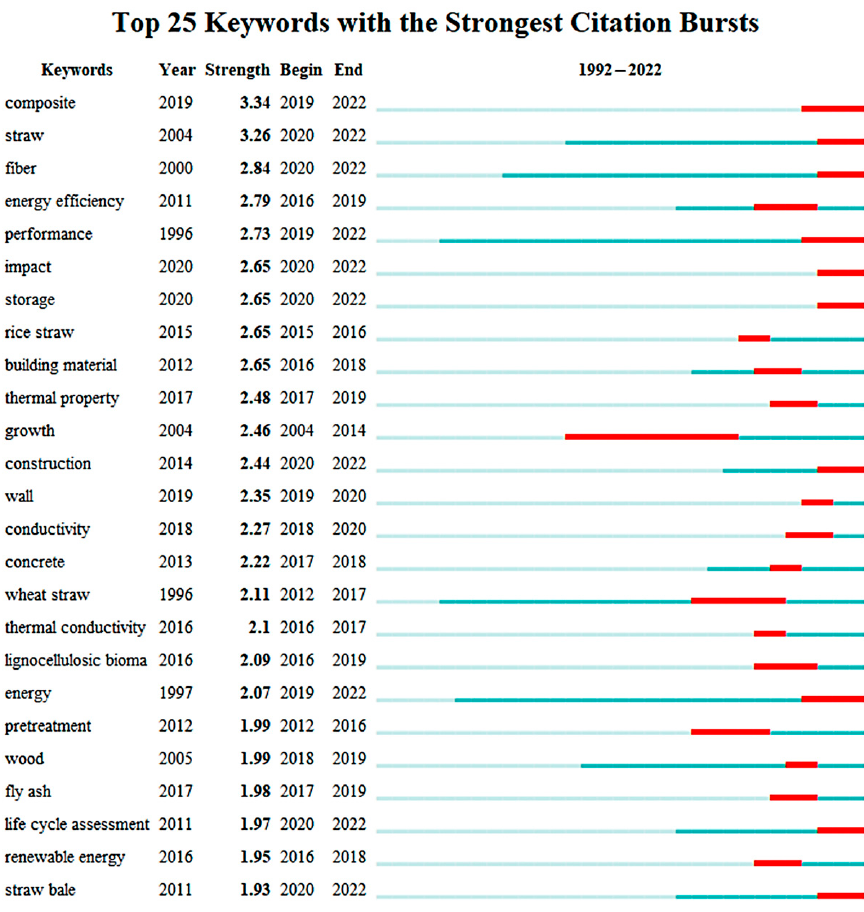
Figure 8. Analysis of the top 25 keywords with the strongest citation burst.